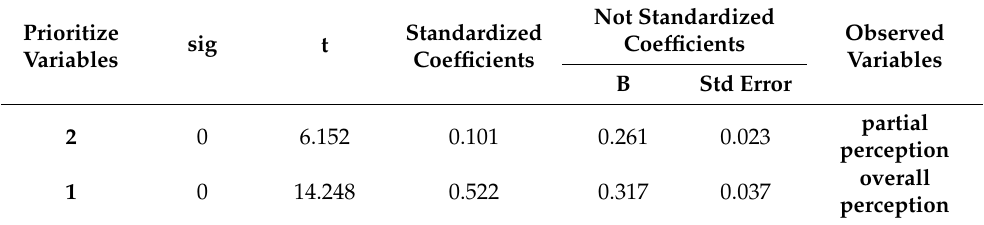
Table 10. Ranking of the total scores obtained for the overall perception compared to the scores obtained for the partial